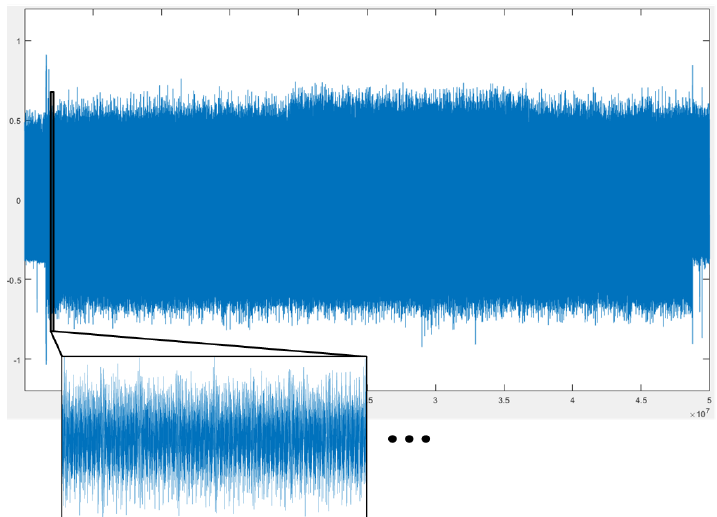
Figure 2. A single power consumption trace of field multiplications for binary Huff curve software implementation on an ARM cortex-m4 processor. The power consumption trace is composed of subtraces corresponding to field multiplications.